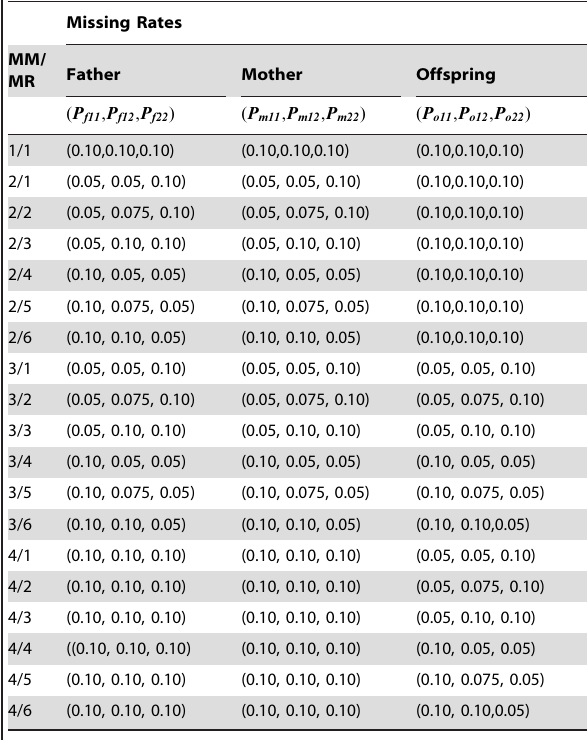
Table 8. Type I error rates at 1% significance level under the null hypothesis of h ~ 0 : 5